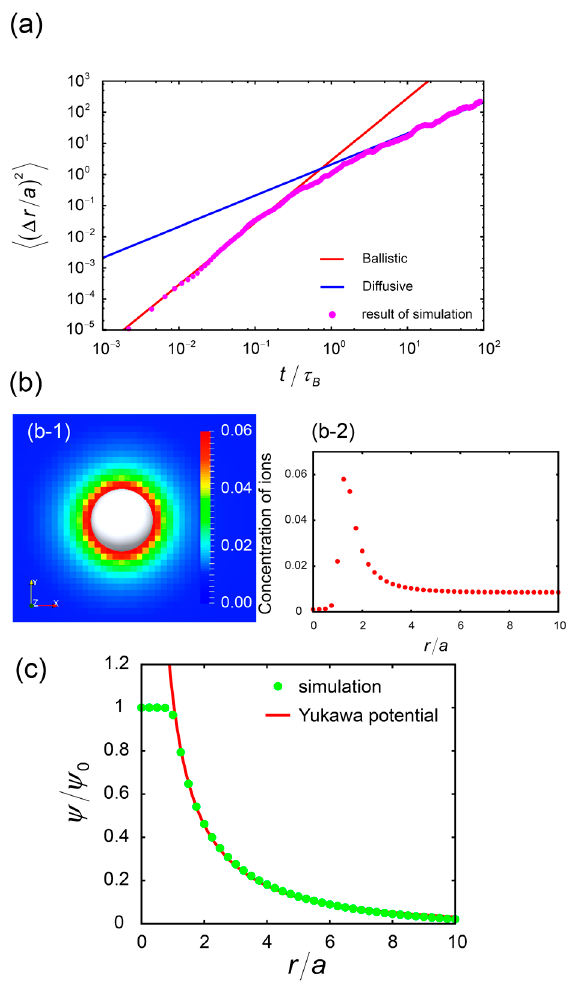
Figure 7. ( a ) Brownian motion of charged cells from the calculation of the mean square displacement of cells. The Brownian motion of cells exhibited a continuous change from ballistic (below τ B ) to diffusive motion (above τ B ). The horizontal axis indicates time scaled by the Brownian time, and the vertical axis indicates the MSD scaled by the radius of cells. The red and blue solid lines represent the ballistic motion and diffusional motion, which are characterized by p 3 k B T { m q t 2 and 6Dt, respectively; ( b ) The concentration distribution of ions surrounding charged cells: ( b-1 ) two-dimensional profile of counter ion concentration and ( b-2 ) concentration profile of counter ions surrounding a cell. This shows the artificially introduced potential k B T χ prevents ions from penetrating into the cell; ( c ) Electrostatic potential of charged cells. Screened-coulomb or Yukawa potential allowed us to fit the profile. All of the results in this figure were obtained from three-dimensional simulations with box sizes of 128 × 128 × 128.